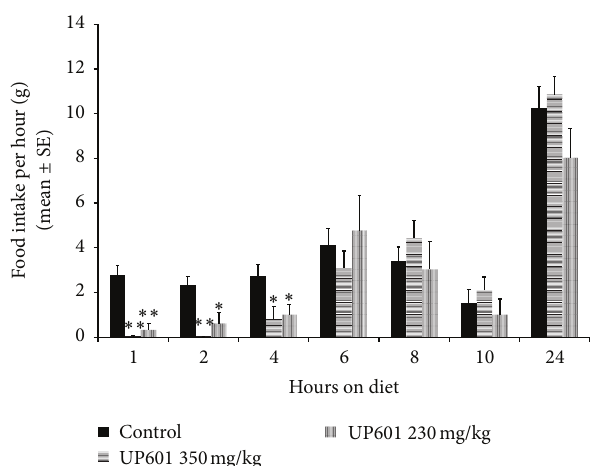
Figure 2: Cumulative food intake by rats treated with UP601 at 230 and 350 mg/kg in the acute food intake study. ∗∗ 𝑃 ≤ 0.0001 ; ∗ 𝑃 ≤ 0.001 ; † 𝑃 ≤ 0.05 .